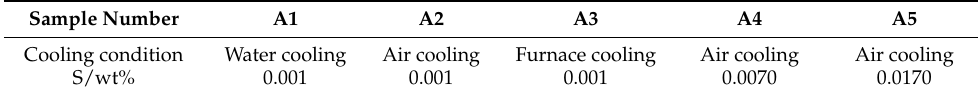
Table 2. Cooling conditions and S content of the steel samples.